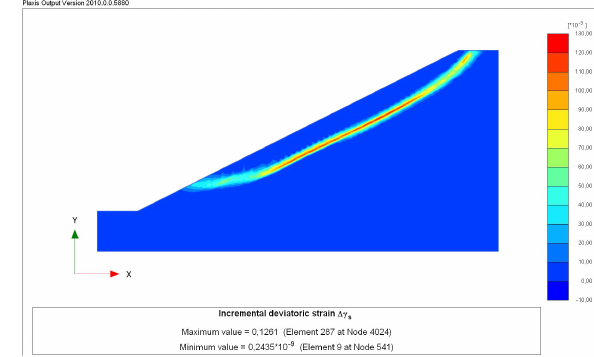
Figure 10: Theoretical embankment destruction mechanism of a flood embankment model, corresponding to the value of the stabil- ity factor F = 1.09.